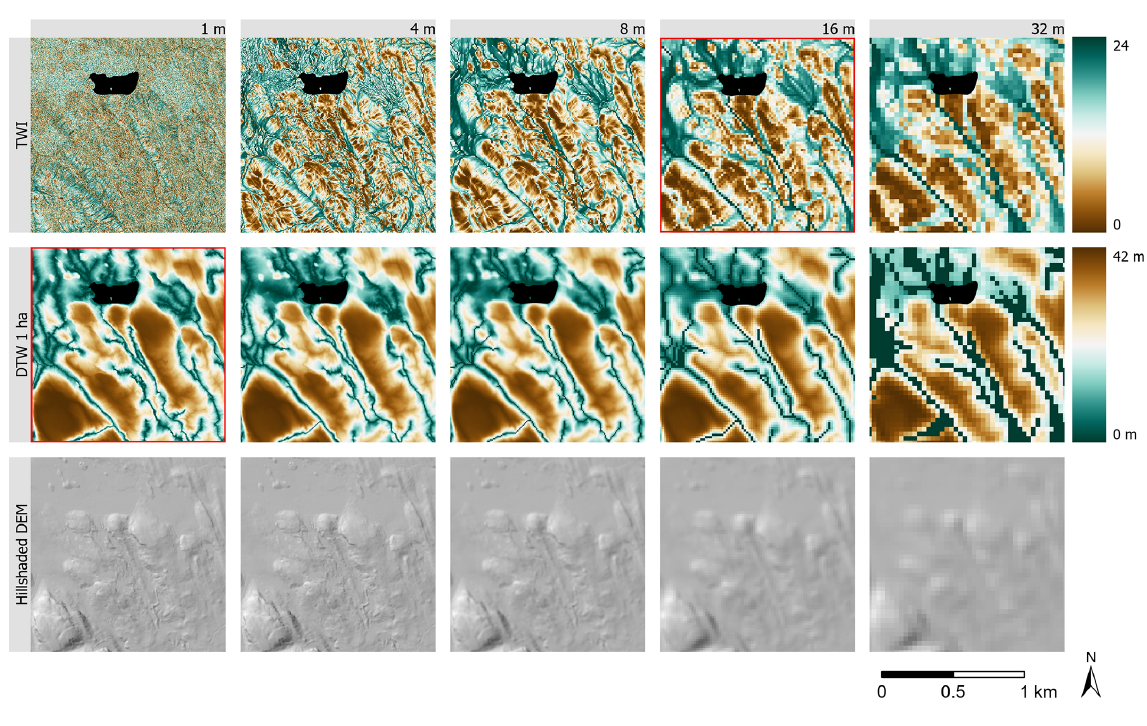
Figure 5. Maps of TWI, DTW and hill-shaded DEM at 1, 4, 8, 16 and 32m resolution. Best-performing rasters in the OPLS analysis are outlined in red.